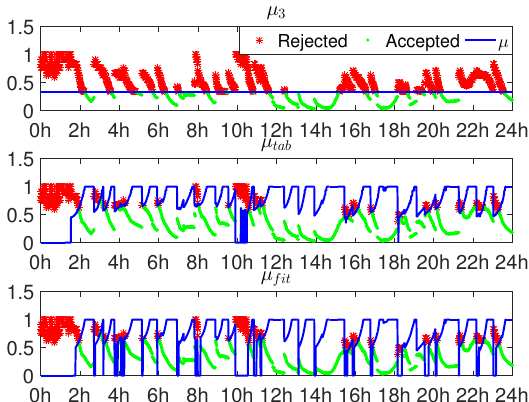
Figure 7. The ratio of AR and µ values in one day. The upper, middle and lower panels relate to µ 3 , = 0.01. µ tab and µ fit , with P tol f